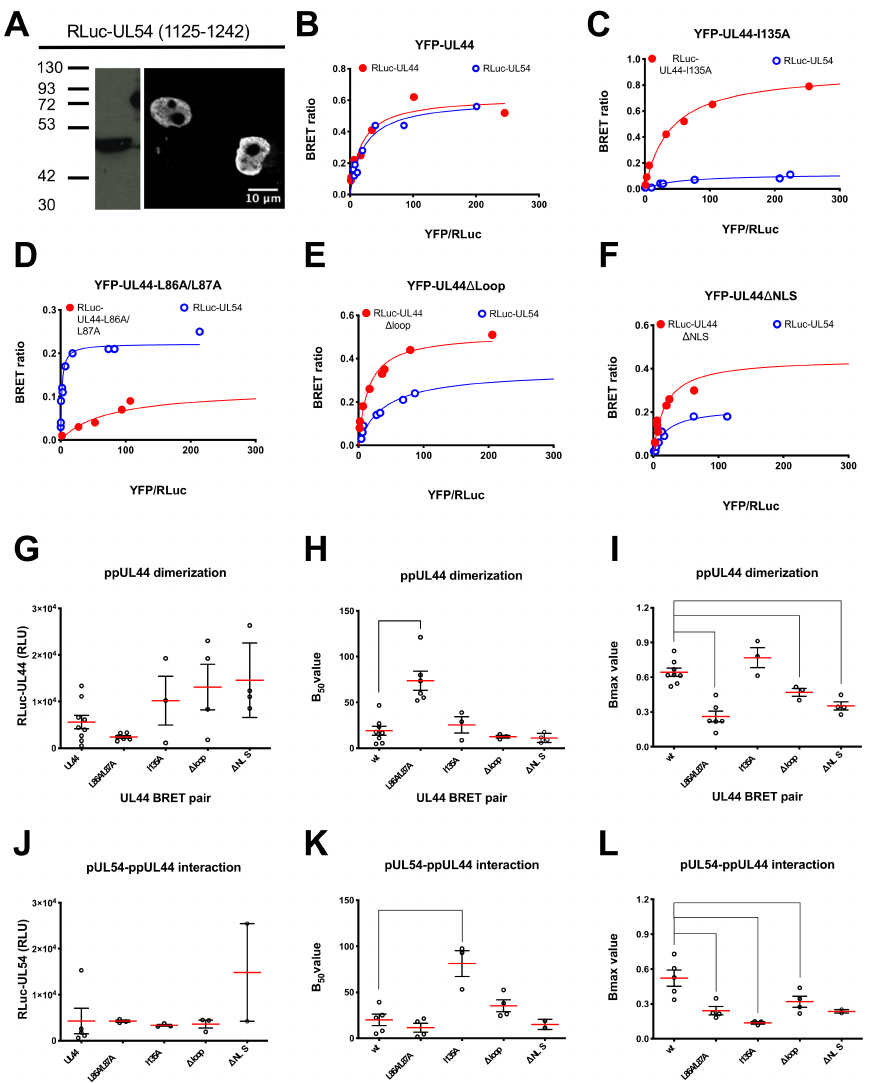
Figure 4. Assessment of the effect of substitutions within ppUL44 individual domains differently affect protein dimerization and holoenzyme formation in living cells. HEK293T cells were transfected to transiently express the indicated RLuc-UL44 (red) or RLuc-UL54 (blue) fusion proteins either alone or in the presence of increasing amounts of plasmids encoding for YFP-tagged ppUL44 proteins indicated in Figure 1B (range 0–500 ng); 48 h later, cells were processed for immunofluorescence and Western blotting ( A ) or BRET measurements as described in the Materials and Methods section ( B – L ). Subcellular localization and molecular weight of RLuc-UL54 was assessed using a mouse monoclonal antibody against RLuc ( A ). The BRET ratio relative to the indicated BRET pair was plotted against the YFPNet/RLuc ratio to generate BRET saturation curves ( B – F ). Representative data from at least three independent experiments are shown. RLuc activity ( G , J ), B 50 ( H , K ) and BRET ratio ( I , L ) values rela- tive to the indicated YFP-UL44 substitution derivatives in combination with either the corresponding RLuc-UL44 derivatives ( G – I ) or RLuc-UL54 ( J – L ) are shown as individual measurements (empty circles) and means (red horizontal lines) ± standard error of the mean (black vertical lines), relative to at least three independent experiments, along with the p -value as compared to wild-type UL44, calculated using the unpaired t-student test with Welch’s correction: **** = p ≤ 0.0001; ** = p < 0.005; * = p ≤